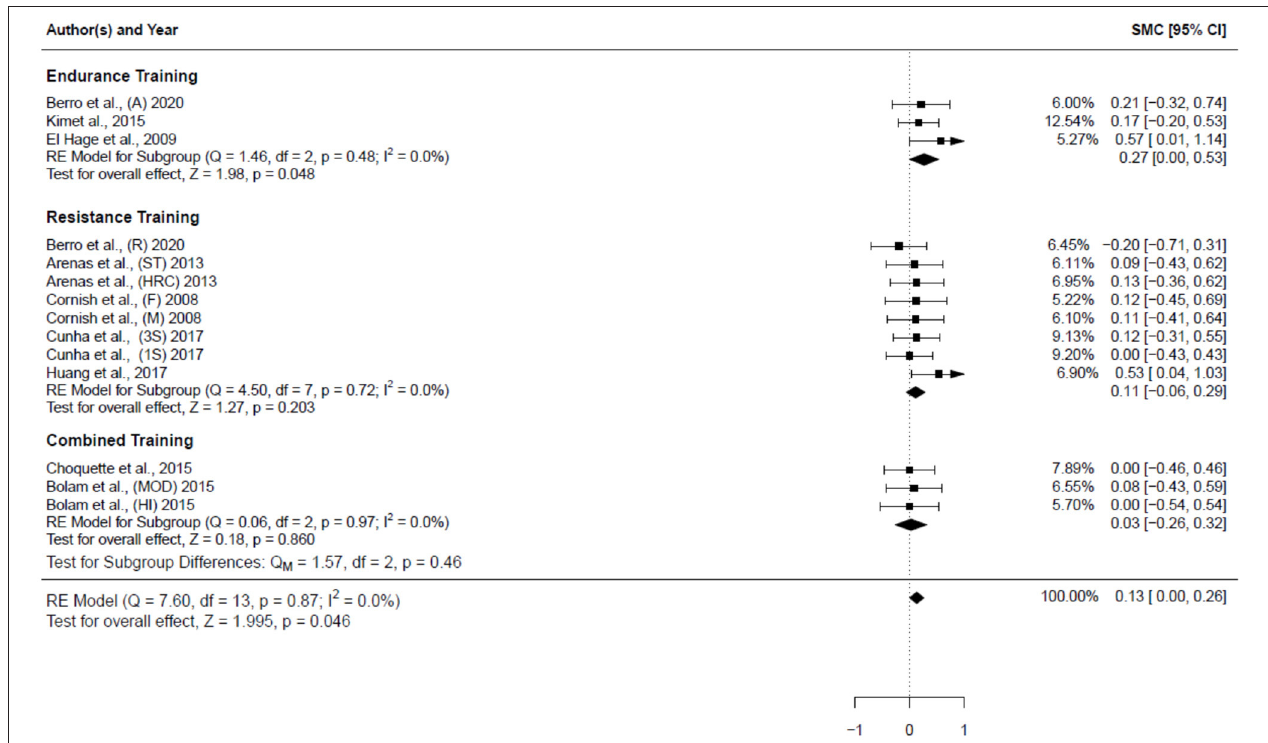
FIGURE 2 | Forest plot for the estimated standardized effect size changes in WB BMD. Three subgroups were included endurance training, resistance training, and combined training. The black squares represent the standardized mean difference, while the left and right extremes of the squares represent the corresponding 95% confidence intervals. The middle of the black diamond represents the overall standardized mean difference, while the left and right extremes of the diamond represent the corresponding 95% confidence intervals. SMC, standardized mean change; A, aerobic; R, resistance; ST, strength training; HRC, Hight resistance circuit; F, females; M, males; 3S, 3 sets; 1S, 1 set; MOD, moderate dose impact loading; HI, high-dose impact